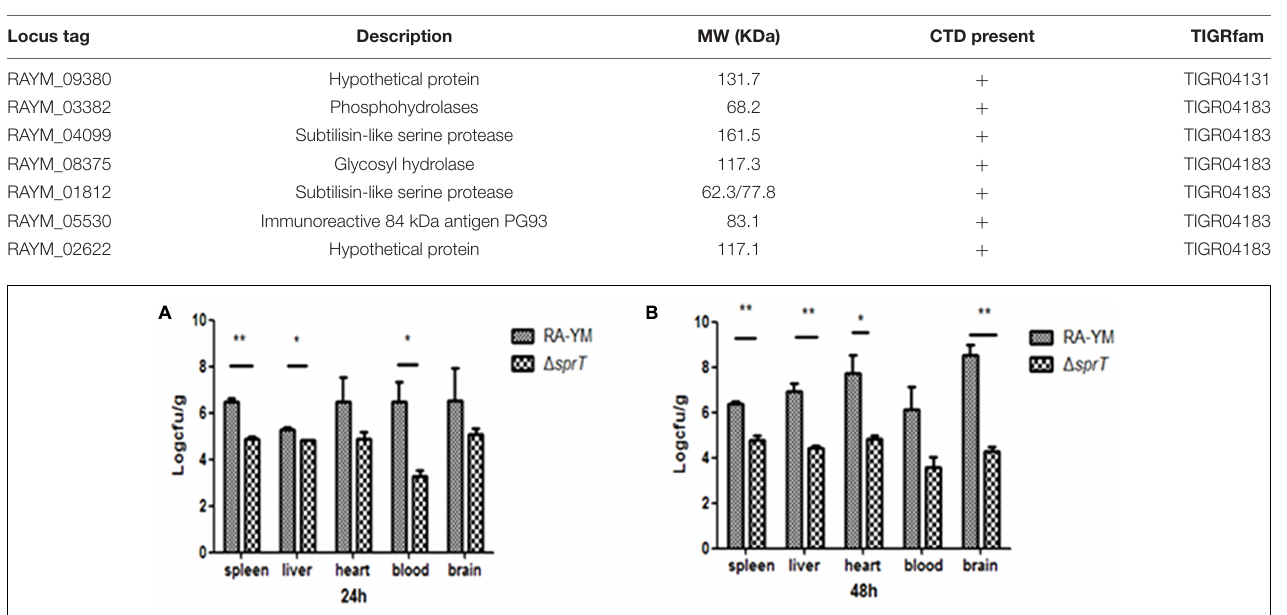
FIGURE 4 | Bacterial load in blood and organs of ducklings infected with wild-type strain RA-YM or mutant strain (cid:49) sprT . Tissue burden in groups infected with RA-YM or (cid:49) sprT 24 h (A) and 48 h (B) post challenge. Data represent mean ± standard deviation of five animals. Data were analyzed with Student’s t- test ( ∗ P < 0.05, ∗∗ P < 0.01).